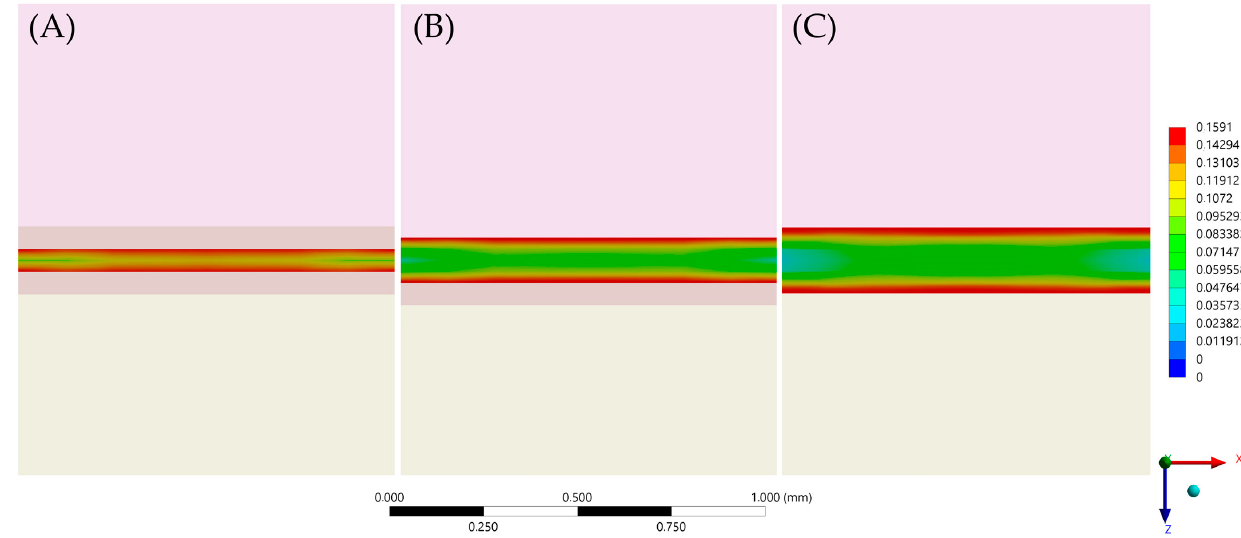
Figure 6. First principal stress (tensile) distribution in the cement layer for each evaluated group. ( A ) Models with 60 μ m of cement layer thickness; ( B ) Models with 120 μ m of cement layer thickness and ( C ) Models with 180 μ m of cement layer thickness.